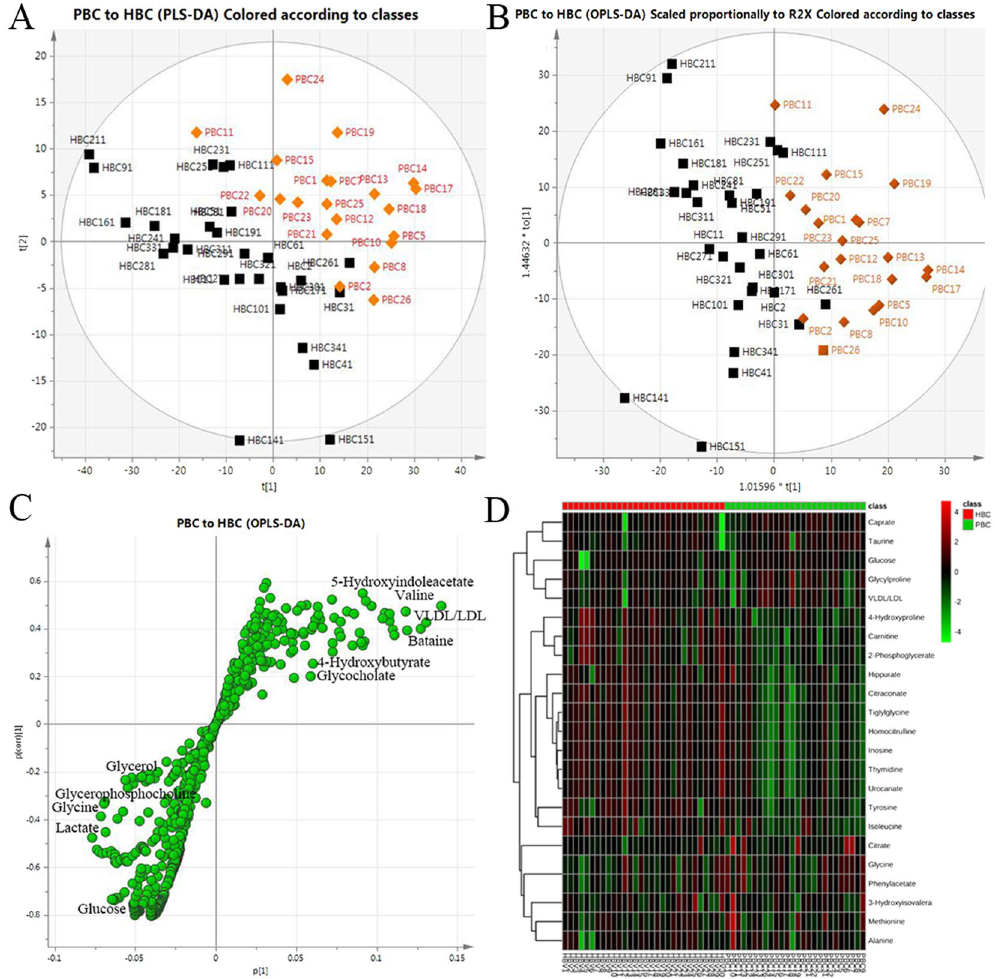
Figure 2. The serum PCA score plot ( A ), OPLS-DA ( B ), S-plot ( C ) and heat map ( D ) used to classify the PBC and HBC patients obtained a satisfactory validation. A total of 25 metabolites were analyzed, and the results indicated that the PBC and HBC patients could be separated based on these